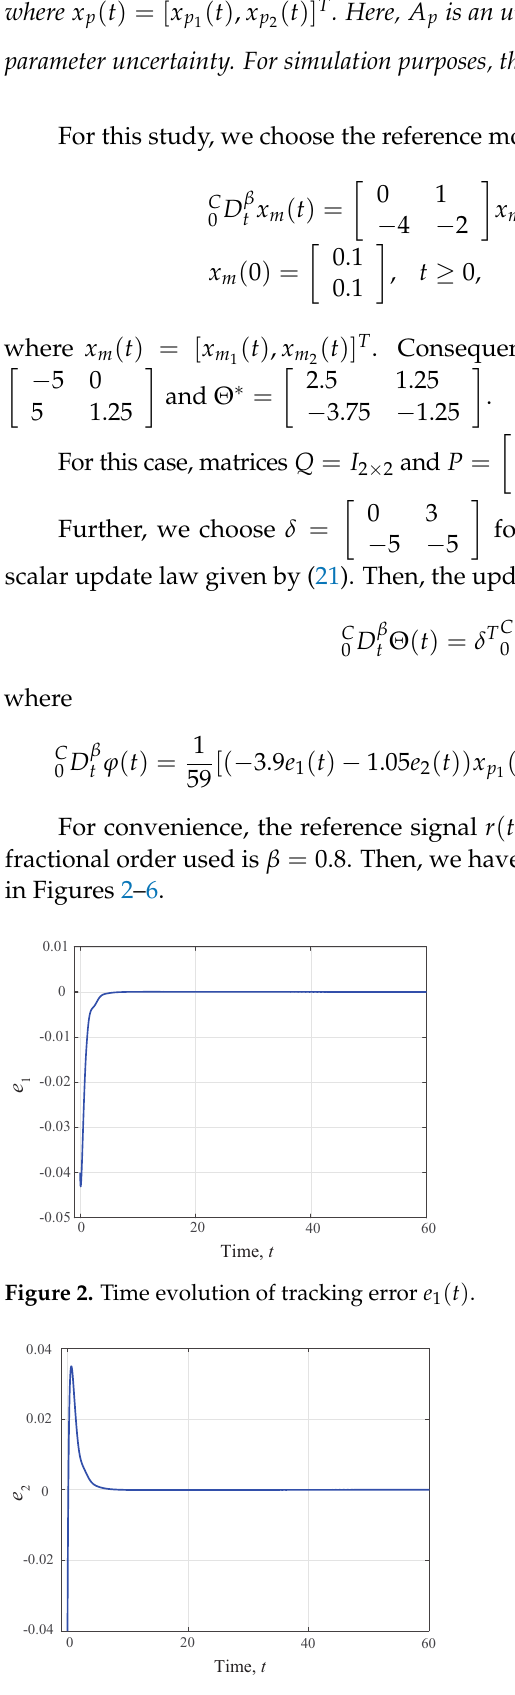
Figure 3. Time evolution of tracking error e 2 ( t )